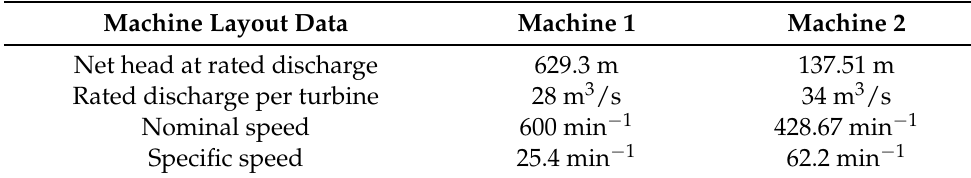
Table 3. Machine layout data and specific speed.